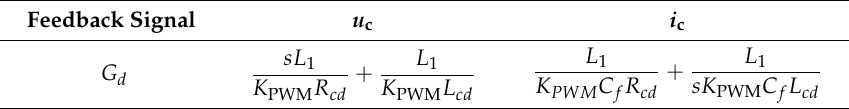
Table 4. The feedback signal comparison for virtual impedance.